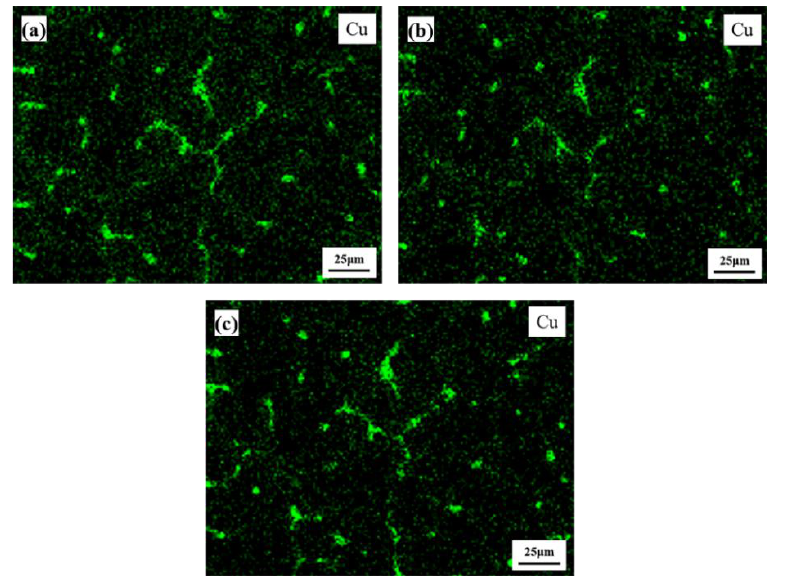
Figure 6. EDS elemental distribution of Cu with QISOZ magnification of 500 times at 100 °C ( a ), 200 °C ( b ) and 300 °C ( c ).